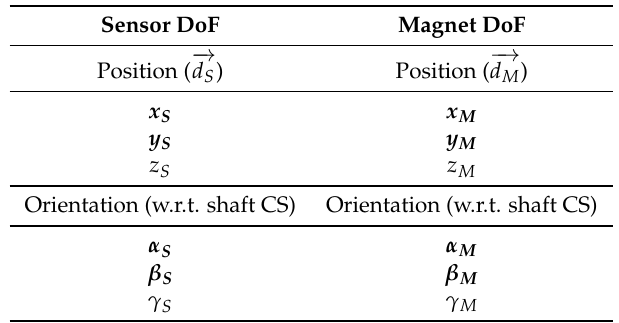
Figure 2. Schematic overview of the different coordinate systems. Table 1. Overview of degrees of freedom (DoF). DoF in bold were used in the model